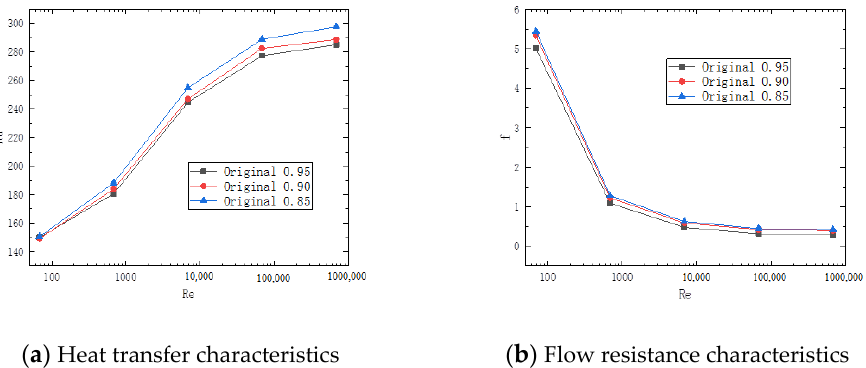
Figure 7. Heat transfer and flow resistance characteristics.